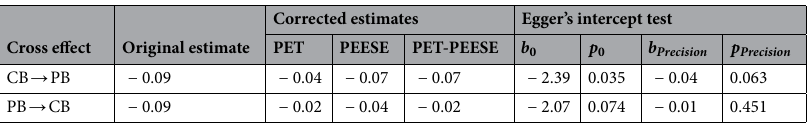
Table 2. Publication bias analyses. The original and corrected meta-analytic point estimates (PET-PEESE) are displayed together with the results of Egger’s intercept test. k = 13; N = 12,696; PET = precision-effect test; PEESE = precision-effect estimate with standard errors; CB = Conspiracy beliefs; PB = COVID-19-related preventive behavior (e.g., social distancing, wearing masks); Full R output is available in supplementary